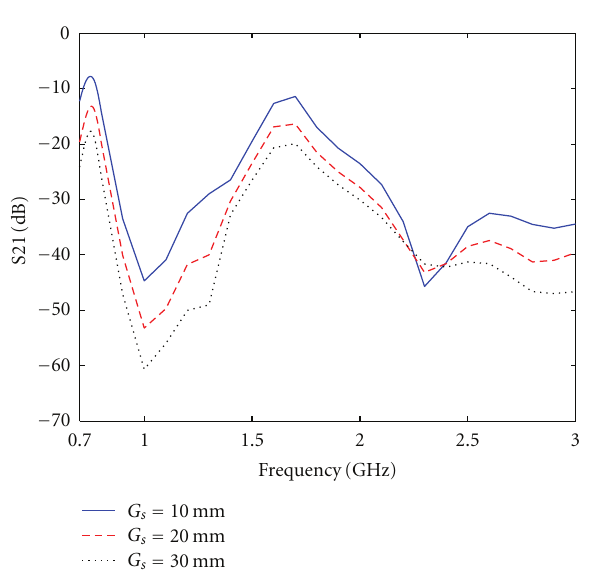
Figure 11: S21 of the antenna with di ff erent G s .